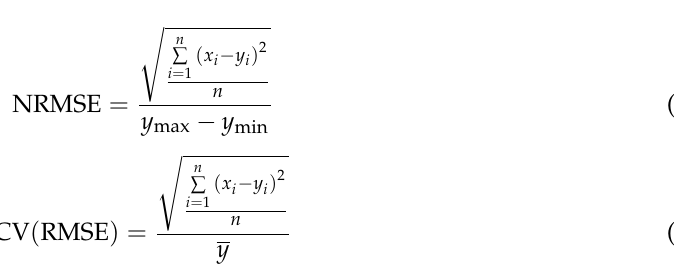
Table 4. Correlation coefficients r between AGB and VIs ( n = 192).